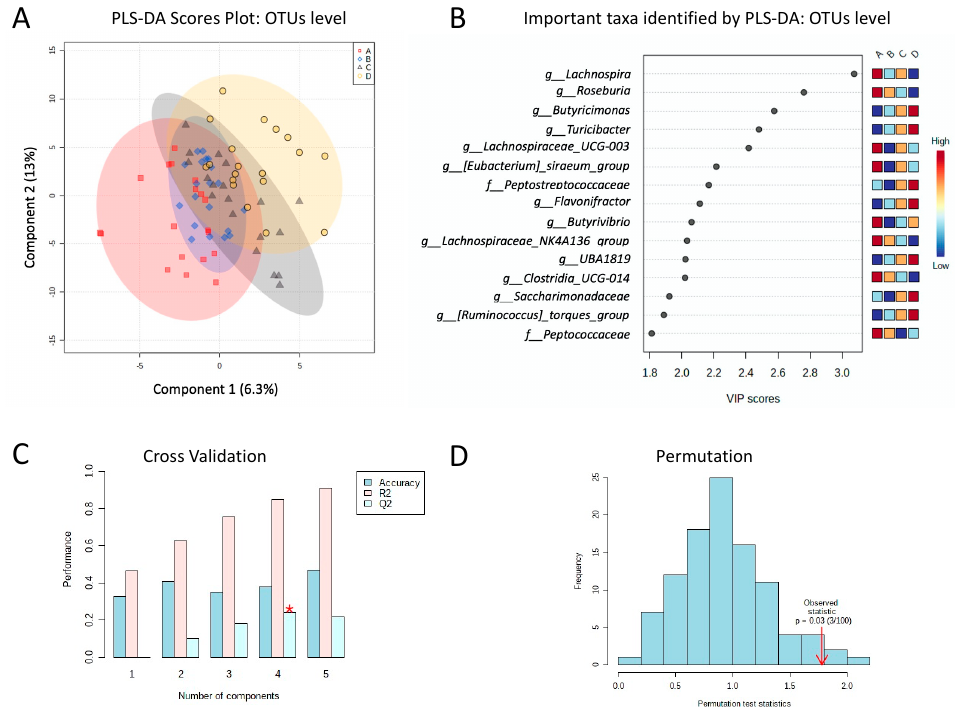
Figure 6. ( A ) Partial least square-discriminant analysis (PLS-DA) two-dimensional (2D) scores plot of the bacterial taxa of each phase of study at OTUS level. The model was established using two principal components; explained variance is in parentheses. ( B ) Loading importance of bacterial taxa in the first PLS-DA component at OTUS level. Colored boxes indicate relative concentrations of the corresponding bacterial taxa in each diet. ( C ) Cross Validation: PLS-DA classification using different number of components based on the accuracy (blue), R2 (pink), Q2 (light blue) by 10-fold CV method. The red star indicates the best classifier. ( D ) Permutation: PLS-DA model validation by permutation tests based on separation distance. The p value based on permutation is p = 0.03 (3/100). VIP: Variable Importance in Projection.